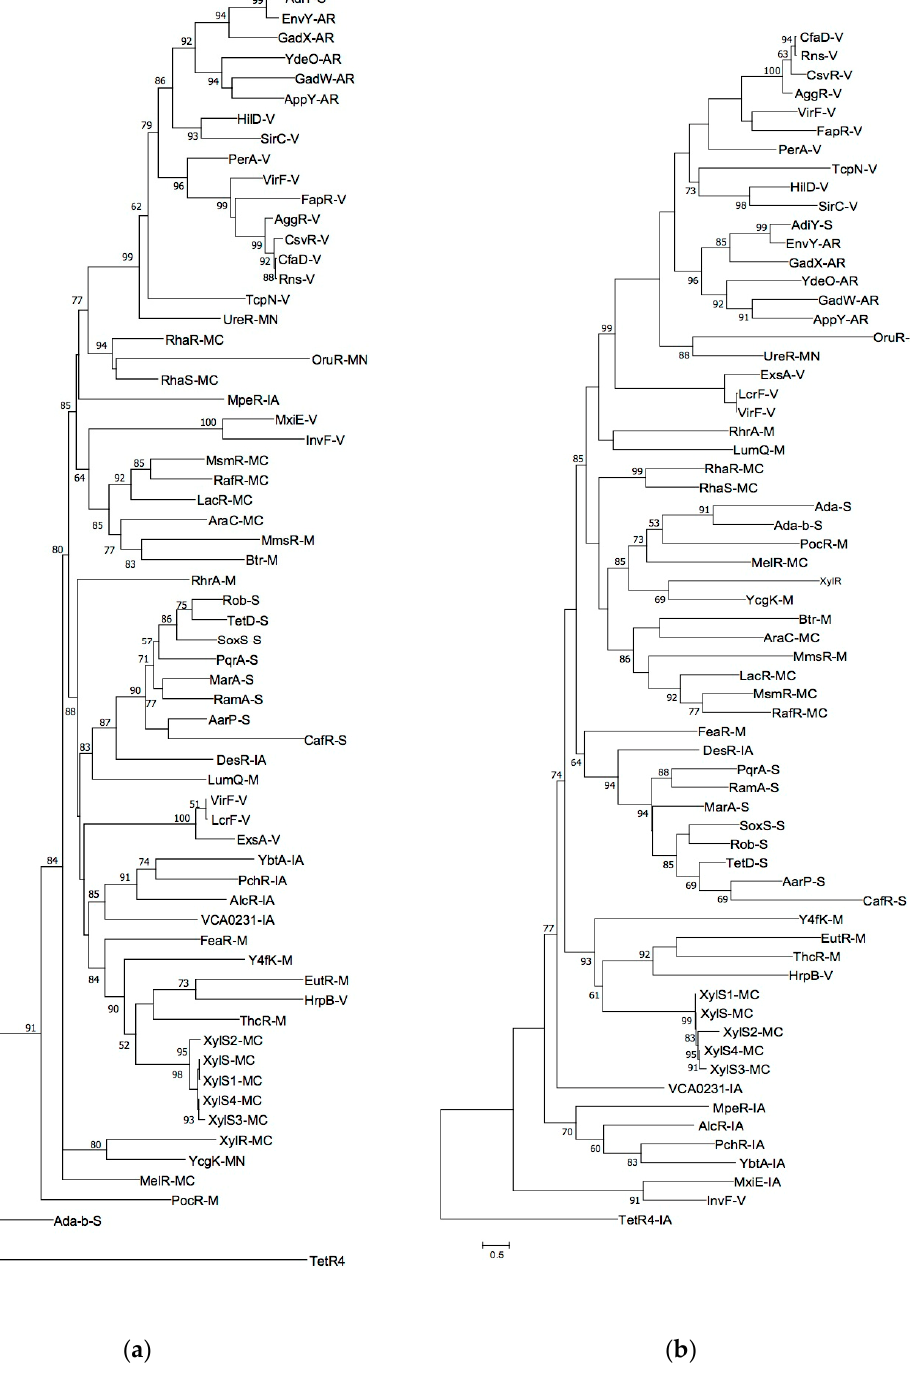
Figure 2. Phylogenetic analysis of representative AraC/XylS transcriptional regulators of different physiological functions. A phylogenetic tree of well-characterized AraC/XylS transcriptional factors was constructed with an alignment of the whole protein ( a ) or the DNA binding domain ( b ) of the 58 AraC/XylS transcription factors used in the report by [42] together with YbtA, PchR, AlcR, MpeR, DesR and the product of VCA0231. Numbers in each branch represent the bootstrap values of 1000 replicates. Broad functional categories are indicated by capital letters as a suffix as follows: general metabolism (M); metabolism of carbon sources (MC); utilization of nitrogen sources (MN); adaptive responses (AR); stress responses (S); virulence (V) and iron acquisition (IA). The bottom ruler bar in each panel indicates number of substitutions per position